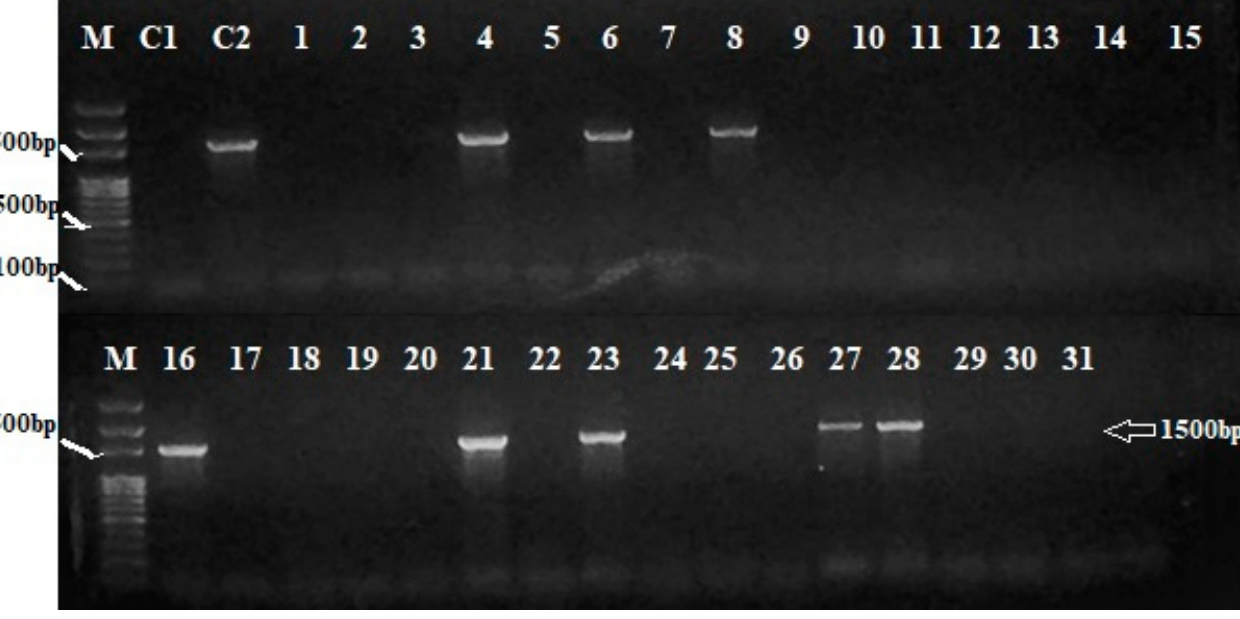
Figure 3. PCR analysis of RILs of rice for the presence of xa5 gene (Arrow showing 1500 bp bands linked to xa 5 gene). M = 100 bp DNA ladder, C1 = Basmati-385, C2 = IRBB59, lines 1–31 = Selected genotypes.